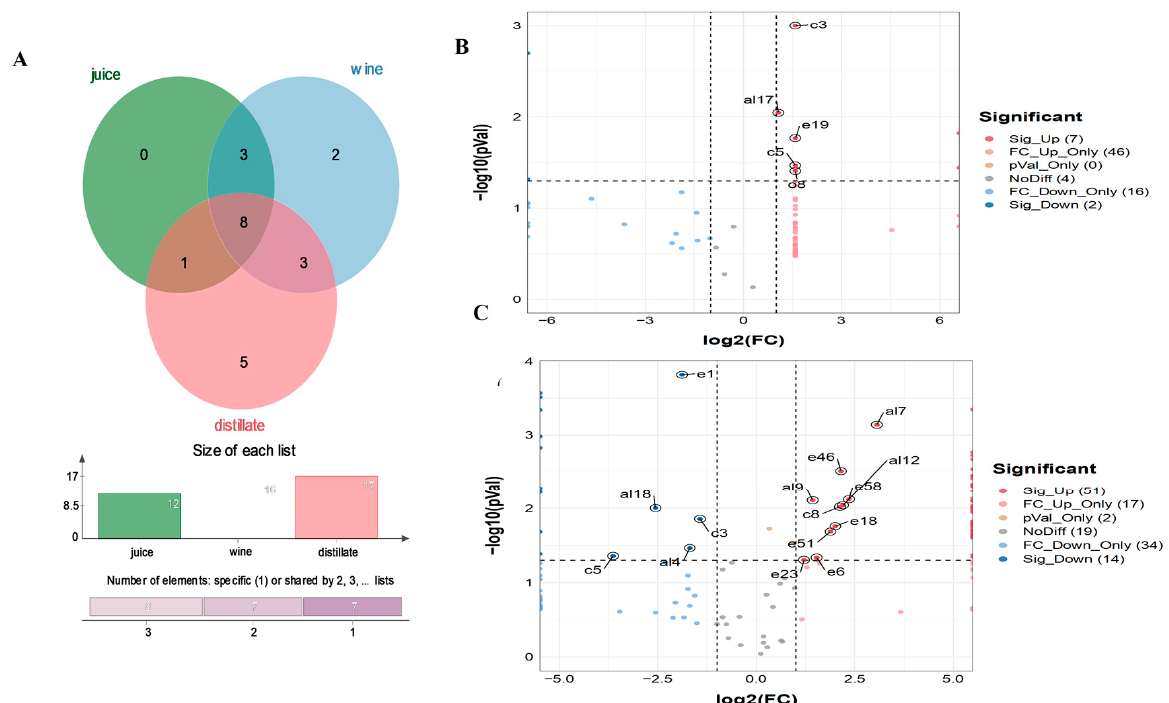
Figure 4. Odour–active compounds and differential metabolites in SJ, SW and DL by GC–MS ( n = 3). ( A ) Venn diagram of odour–active compounds. Volcano plot of metabolites after fermentation ( B ) and distillation ( C